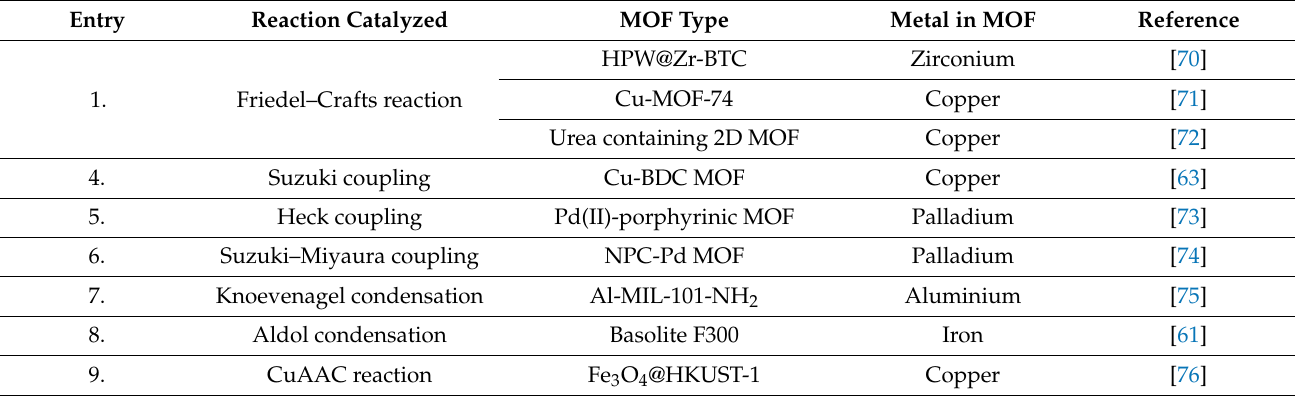
Table 3. Several reactions catalyzed by MOF-based